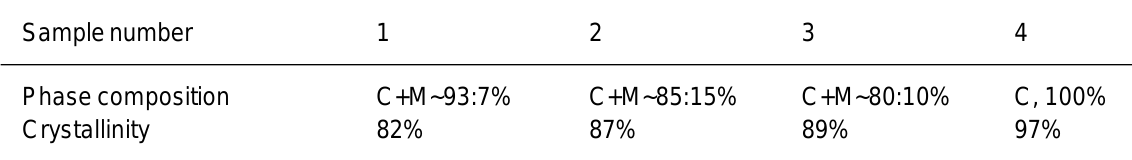
Table 2. Phase composition and crystallinity degree of zirconia based